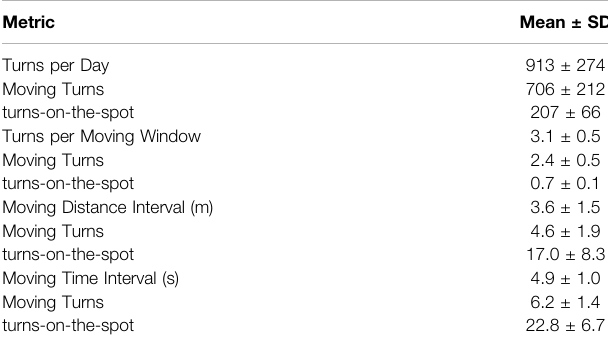
TABLE 3 | Characteristics of all identi fi ed turns. TABLE 4 | Frequencies of moving turns and turns-on-the-spot reported per day and moving window. Time and Distance intervals between turns were calculated during time spent